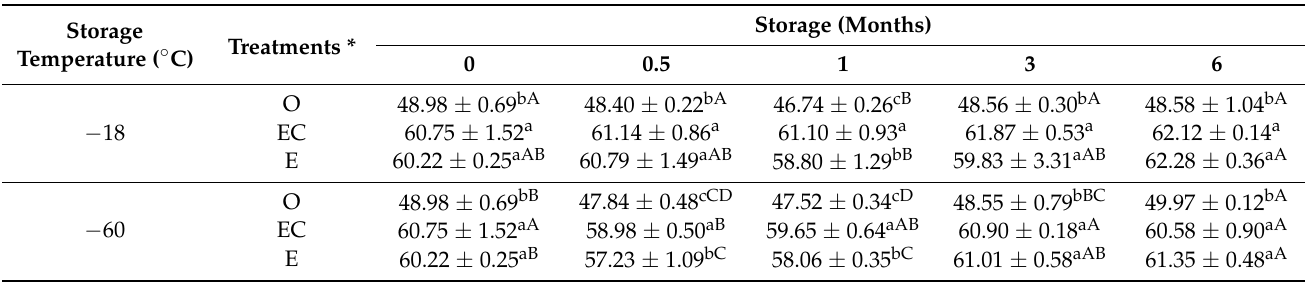
Table 5. Moisture contents (%) of meat analogs with different fat replacers (O, EC, and E) during the freezing storage ( − 18 ◦ C, − 60 ◦ C) for six months.